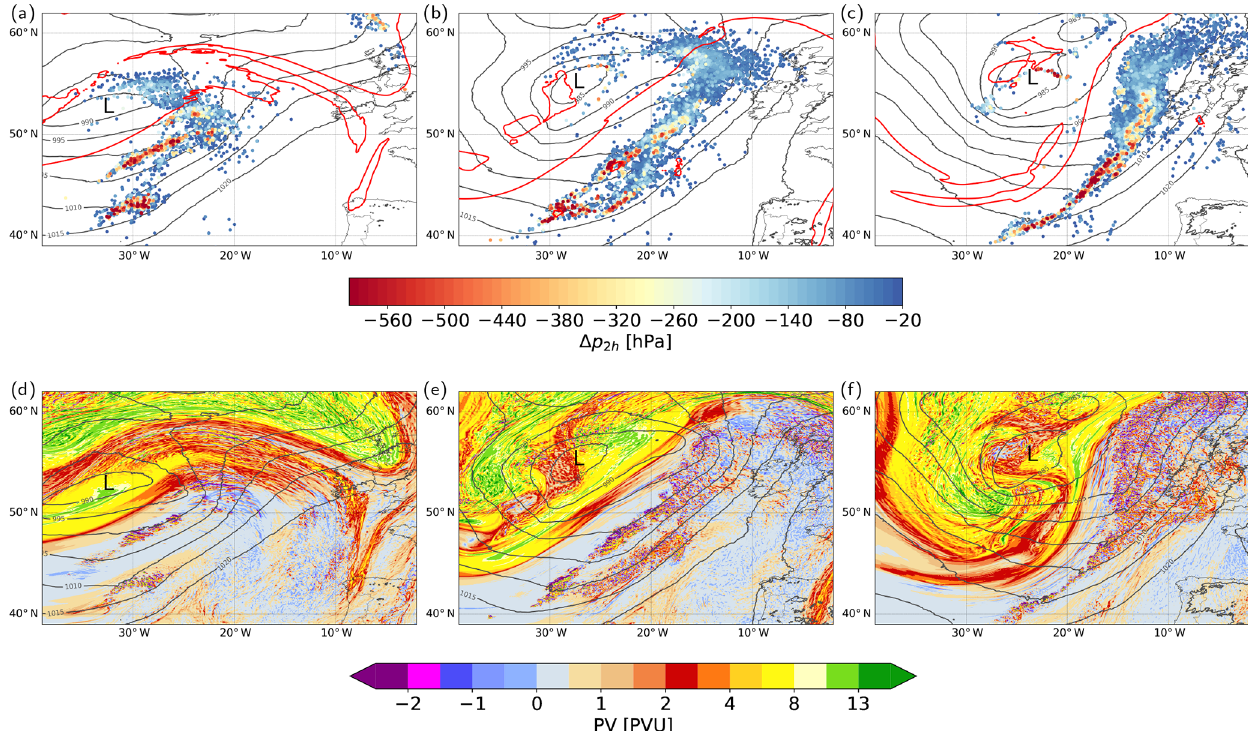
Figure 2. Overview of the WCB ascent for Cyclone Vladiana: (a–c) locations of WCB air parcel ascent (circles; colors indicate centered 2h pressure change, (cid:49)p 2h , along all ascending WCB trajectories, in hPa), SLP (grey contours, in hPa), and 2PVU at 320K (red line) for (from a to c ) 22:00UTC, 22 September; 10:00UTC, 23 September; and 22:00UTC, 23 September. (d–f) PV at 320K and SLP (grey contours, in hPa) for the same times as (a) – (c) . All panels show the position of the cyclone center